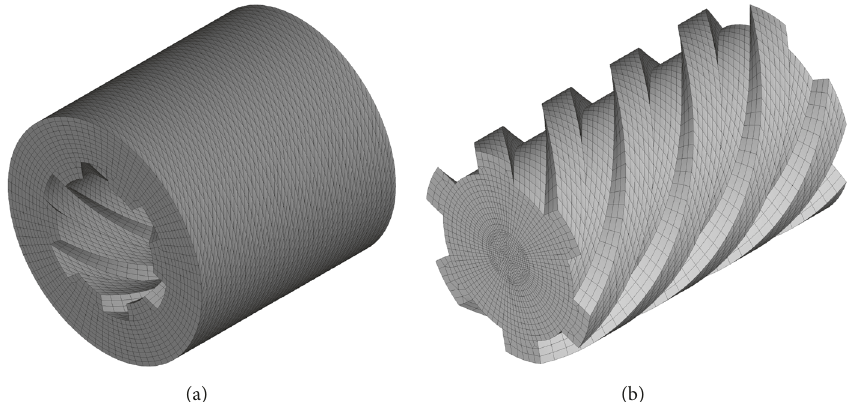
Figure 5: Finite element mesh of the helical spline coupling ( 𝛽 = 135 deg): (a) hub, (b) shaft.